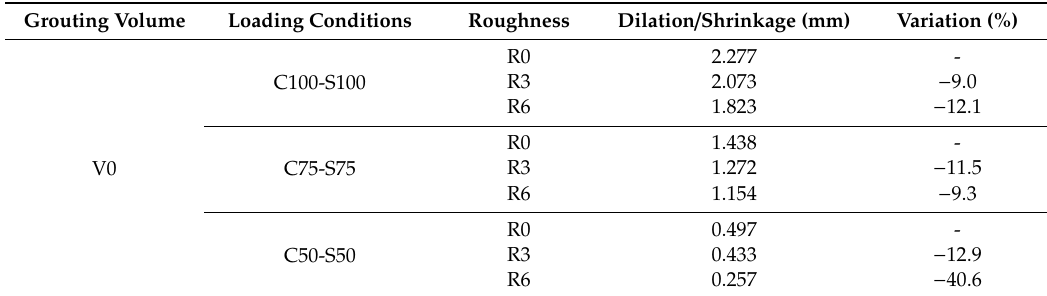
Figure 9. Dilation/shrinkage varying with different roughness values in different loading cases: ( a ) Figure 9. Dilation / shrinkage varying with di ff erent roughness values in di ff erent loading cases: C100 and S100, ( b ) C75 and S75, and ( c ) C50 and S50. ( a ) C100 and S100, ( b ) C75 and S75, and ( c ) C50 and S50. Table 6. Final dilation / shrinkage for specimens with di ff erent roughness values in loading conditions Table 6. Final dilation/shrinkage for specimens with different roughness values in loading conditions without